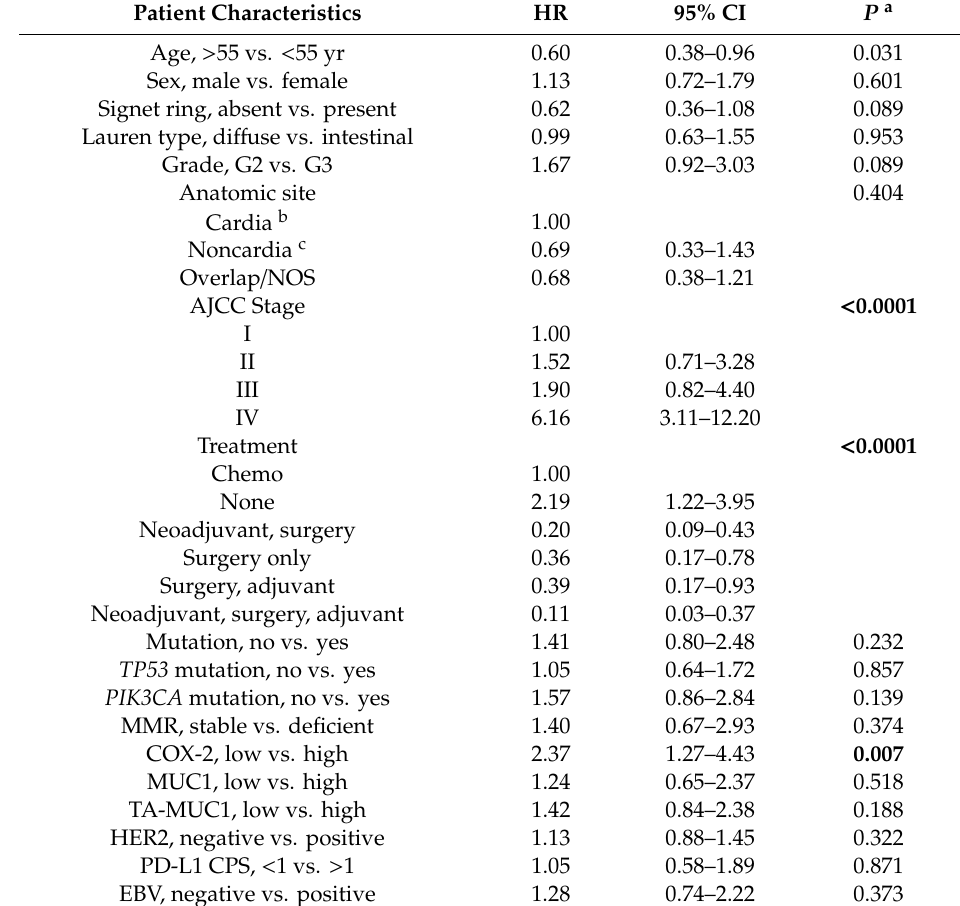
Table 6. Univariate analyses for overall survival in Alaska Native gastric cancer patients.